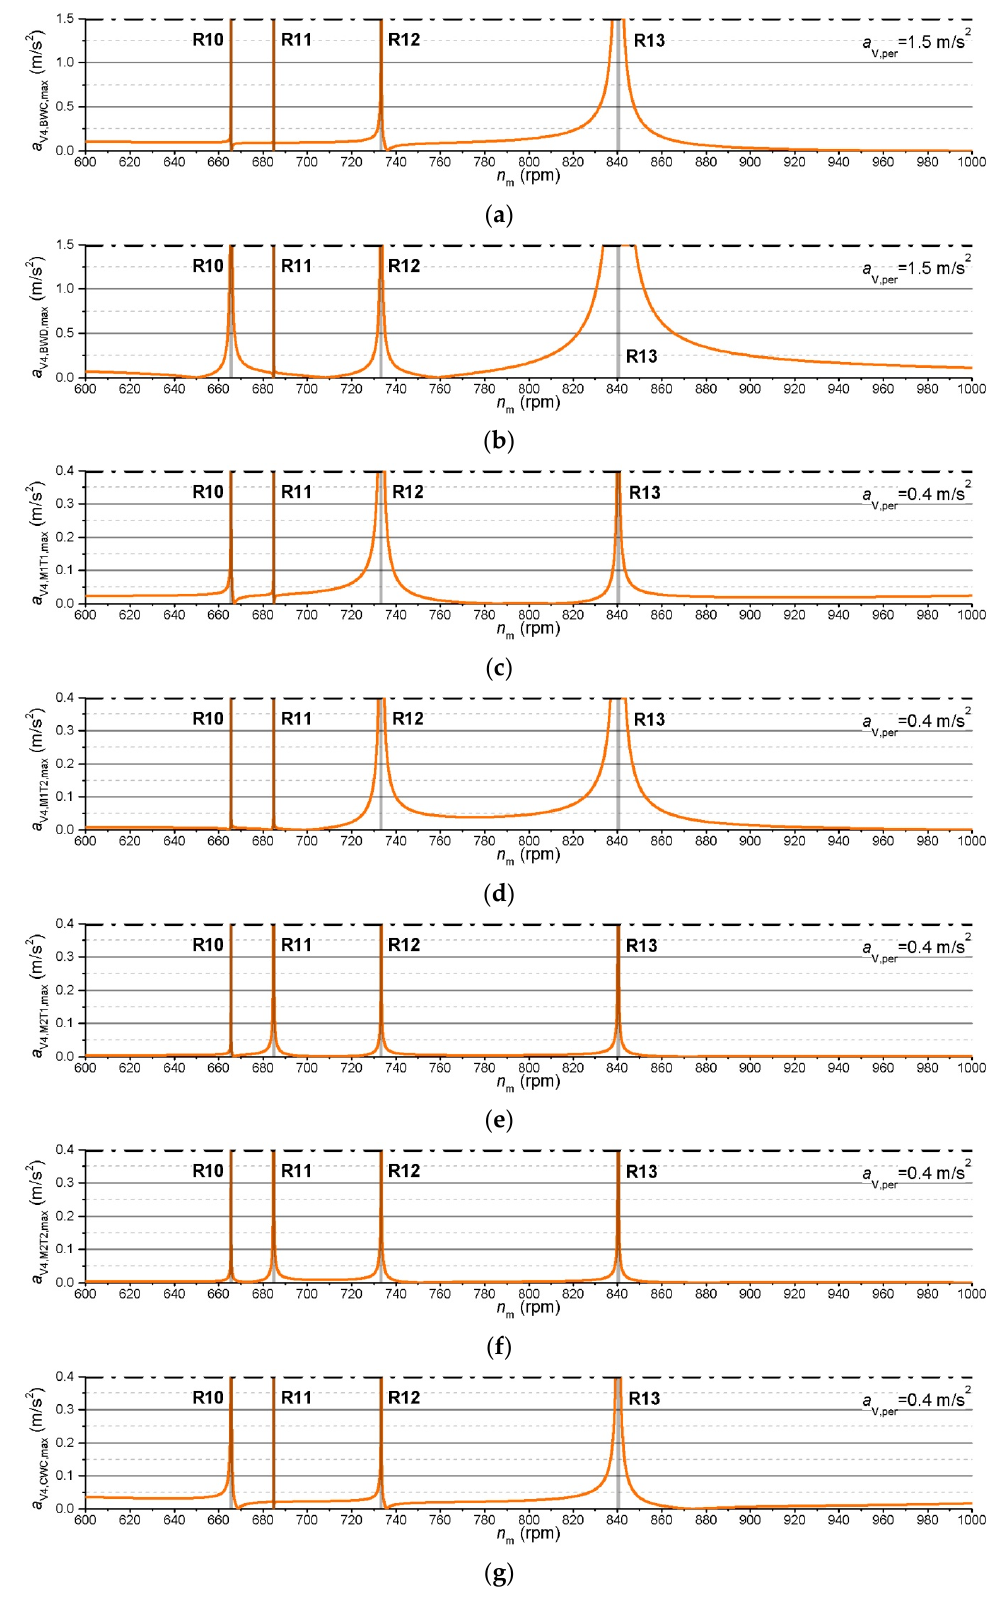
Figure 10. Response to the fourth harmonic of excitation—maximal vertical accelerations of the referent points of the slewing superstructure: ( a ) BWC; ( b ) BWD; ( c ) M1T1; ( d ) M1T2; ( e ) M2T1; ( f ) M2T2; ( g ) CWC.